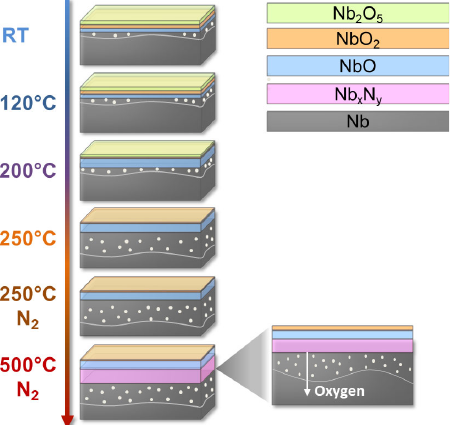
FIG. 9. Schematic representation of the stepwise annealing of Nb(100). The natural oxide layers gradually dissolve, and the liberated oxygen atoms diffuse into the Nb matrix. At 500 °C under a N 2 atmosphere, a Nb x N y layer is formed underneath the remaining niobium